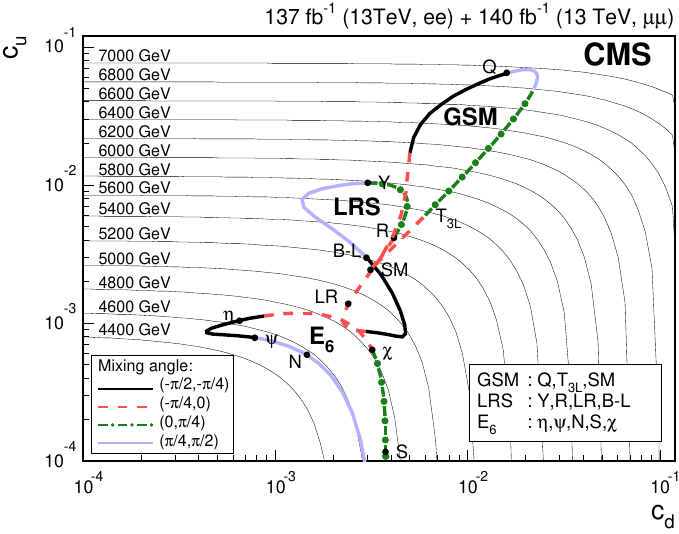
) plane obtained by recasting the combined limit at 95% CL Figure 6 . Lower limits in the ( c , c d u on the Z 0 boson cross section for narrow resonances from dielectron and dimuon channels. For a given Z 0 boson mass, the cross section limit results in a solid thin black line. These lines are labeled with the relevant Z 0 boson masses. The closed contours representing the GSM, LRS, and E model 6 classes are composed of thick curve segments. Each point on a segment corresponds to a particular model, and the location of the point gives the mass limit on the relevant Z 0 boson. As indicated in the lower left legend, the curve segment styles correspond to ranges of the particular mixing angle, for each considered model. The lower right legend indicates constituents of each model